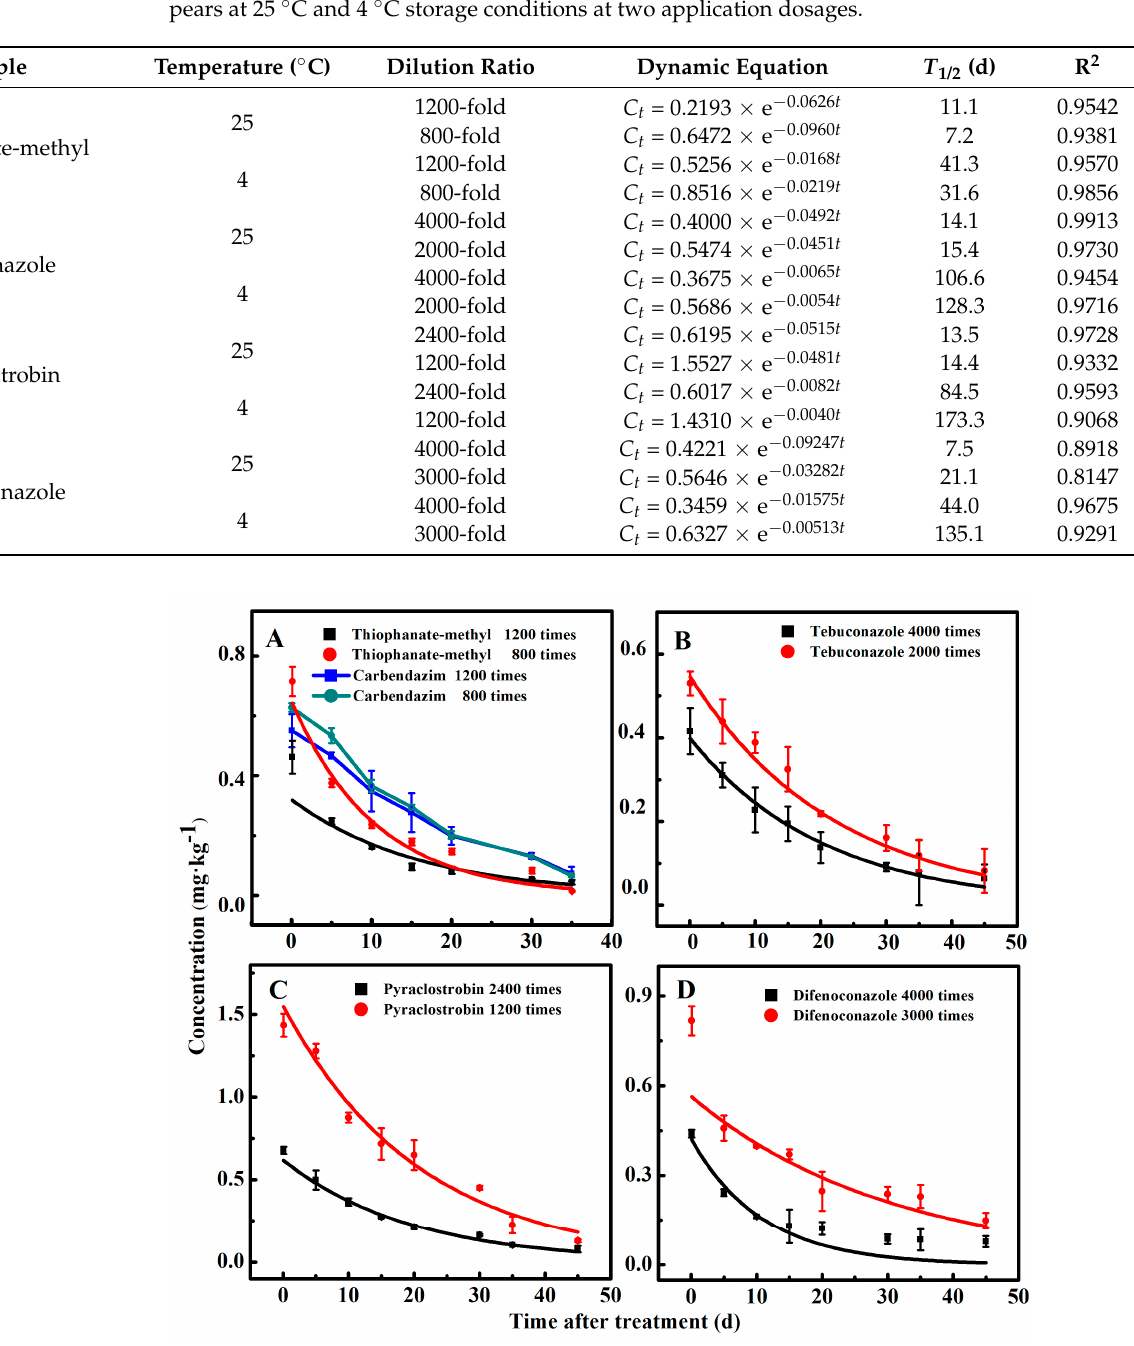
Table 2. Dissipation dynamic parameters of four fungicides and half-lives ( T 1/2 ) of the fungicides in pears at 25 °C and 4 °C storage conditions at two application dosages.